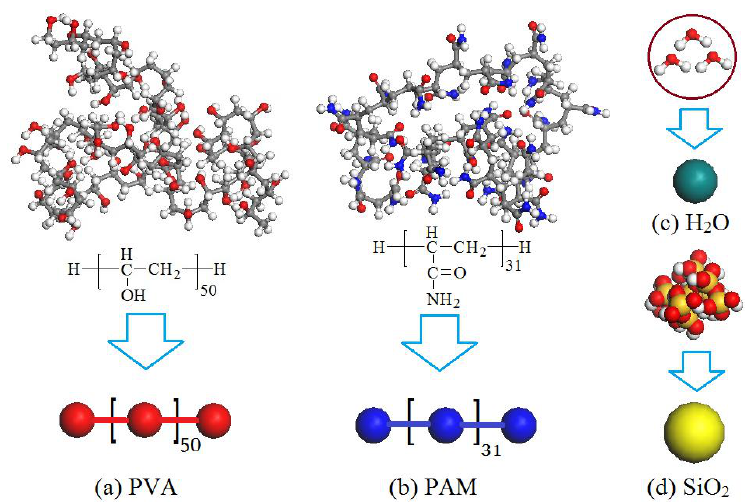
Figure 1. Chemical structures and coarse-grained models of ( a ) PVA: polyvinyl alcohol; ( b ) PAM: polyacrylamide; ( c ) water; and ( d ) SiO 2 .